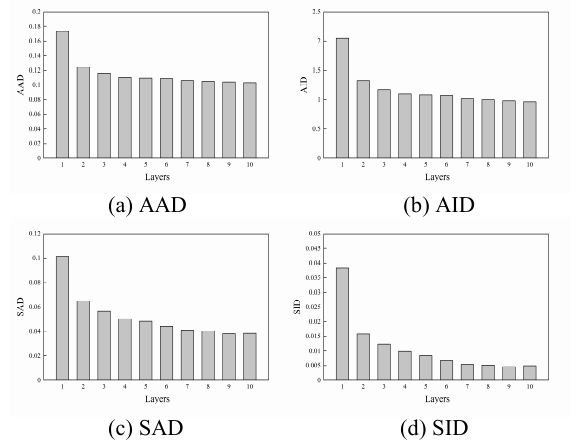
Figure 2. Performance comparison of